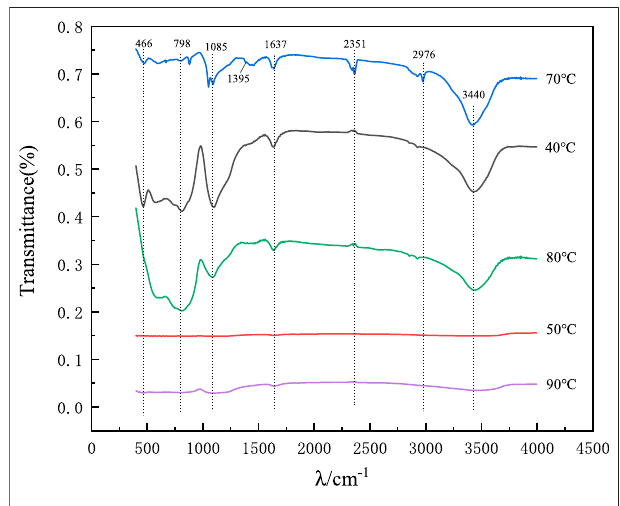
FIGURE 10 | IR spectra of precursors of mineral polymeric materials synthesized at different